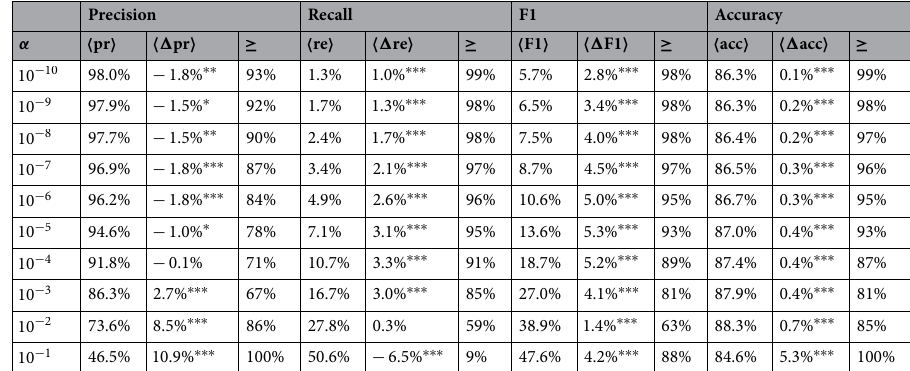
Table 2. The relationship between the network reconstruction performance measures and statistical link validation threshold α . The columns with �·� indicate the averaged measures obtained with our method. The columns with � (cid:31) ·� indicate the mean difference between the measures obtained with our and reference null models. Here the stars indicate the p values for a paired two-sample mean t-test, with an alternative that the mean difference of the samples is not zero. Finally, the ≥ columns indicate the fraction of simulations where the measures obtained with our null model yielded a similar or better performance compared to the reference model. All results are obtained over 1000 simulations. *** p < 0.001 ; ** p < 0.01 ; * p < 0.1